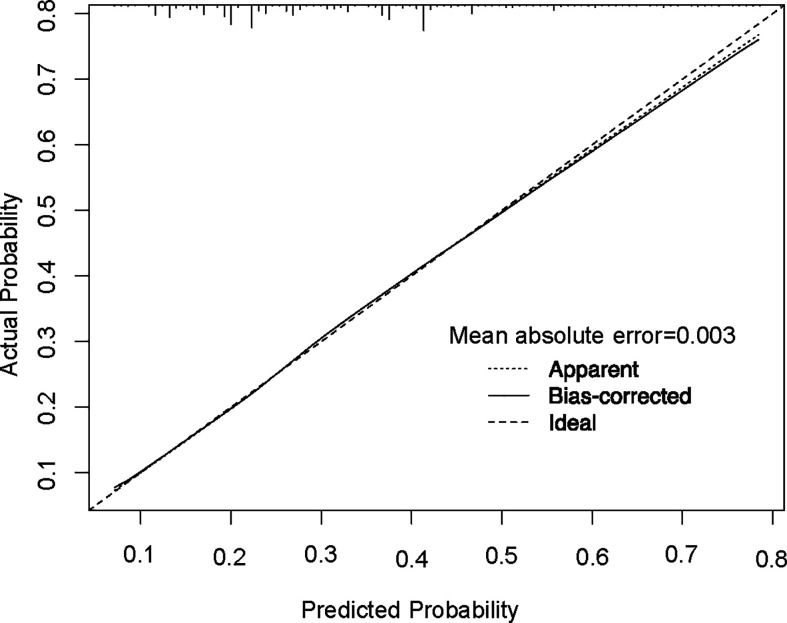
Calibration plot of the nomogram for predicting lymph node status. The performance is estimated by bootstrap 1,000 repetitions. The X-axis plots the nomogram-predicted survival; the Y-axis plots the actual survival.